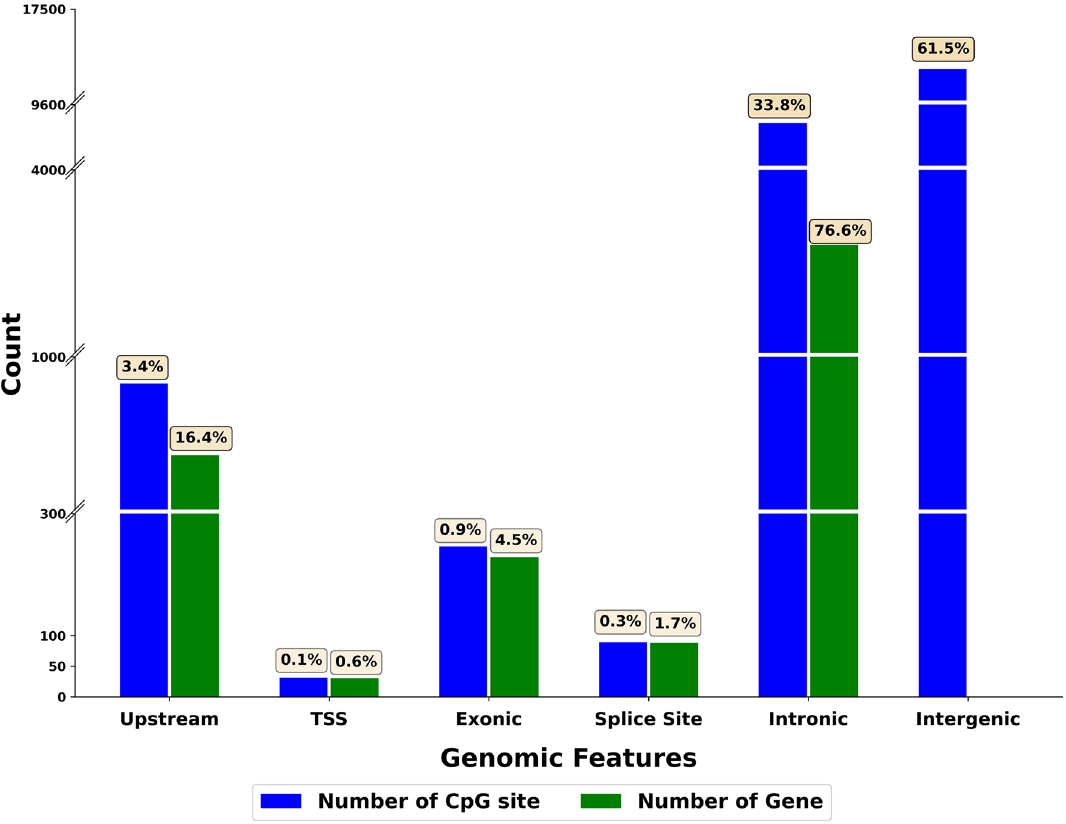
Figure 3. Genomic localization of persistent DNA methylation changes. This figure was created with R software (R version 4.0.3, https:// www.r- proje ct.